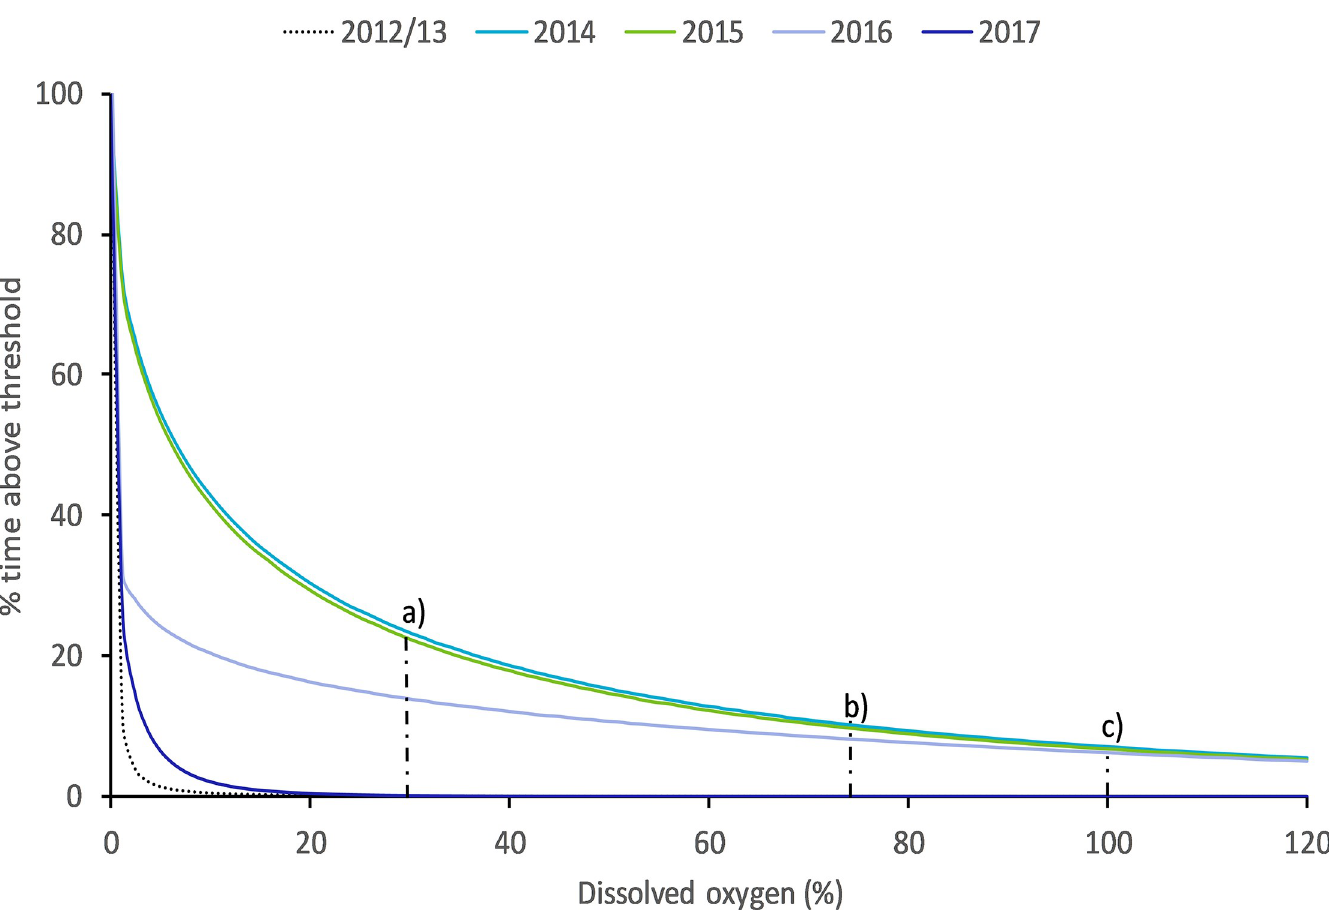
Fig 14. The percentage of time DO exceed any given DO threshold in the Boolgooroo wetland. Vertical dashed lines represent critical values of DO affecting fish species, a) acute trigger value, b) chronic trigger value and b) to c) optimal DO for fish species. From dissolved oxygen guidelines for freshwater habitats of Northern Australia